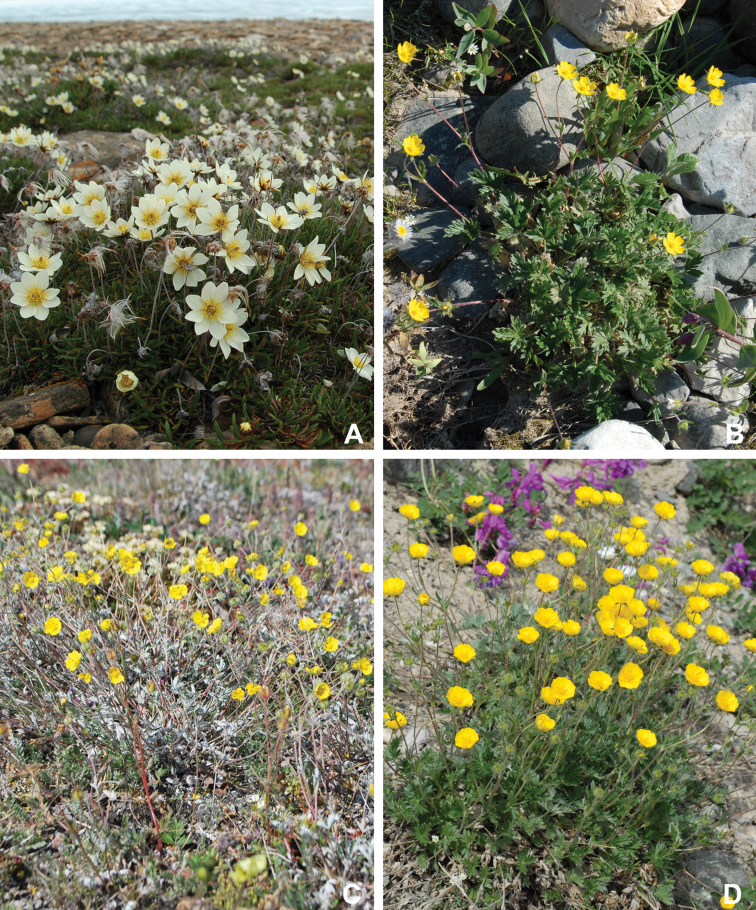
ADryas
integrifolia
subsp.
integrifolia habit, Oterkvik Point, NU, 7 July 2008 BPotentilla
arenosa
subsp.
arenosa habit, Gillespie et al. 10116aCPotentilla
nivea habit DPotentilla
uschakovii habit, Gillespie et al. 9831. Photos A, B, D by L.J. Gillespie and C by B.A. Bennett.